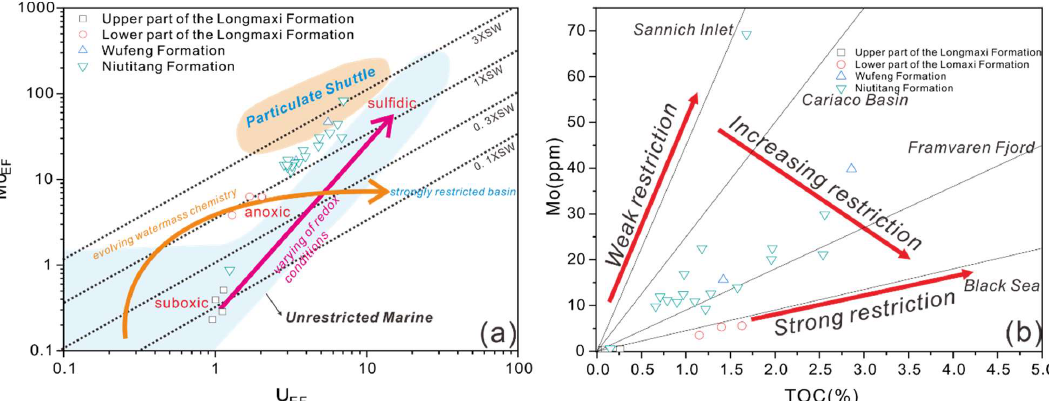
Figure 6. ( a ) Mo EF versus U EF in samples from the Wufeng-Longmaxi and the Niutitang Formations.